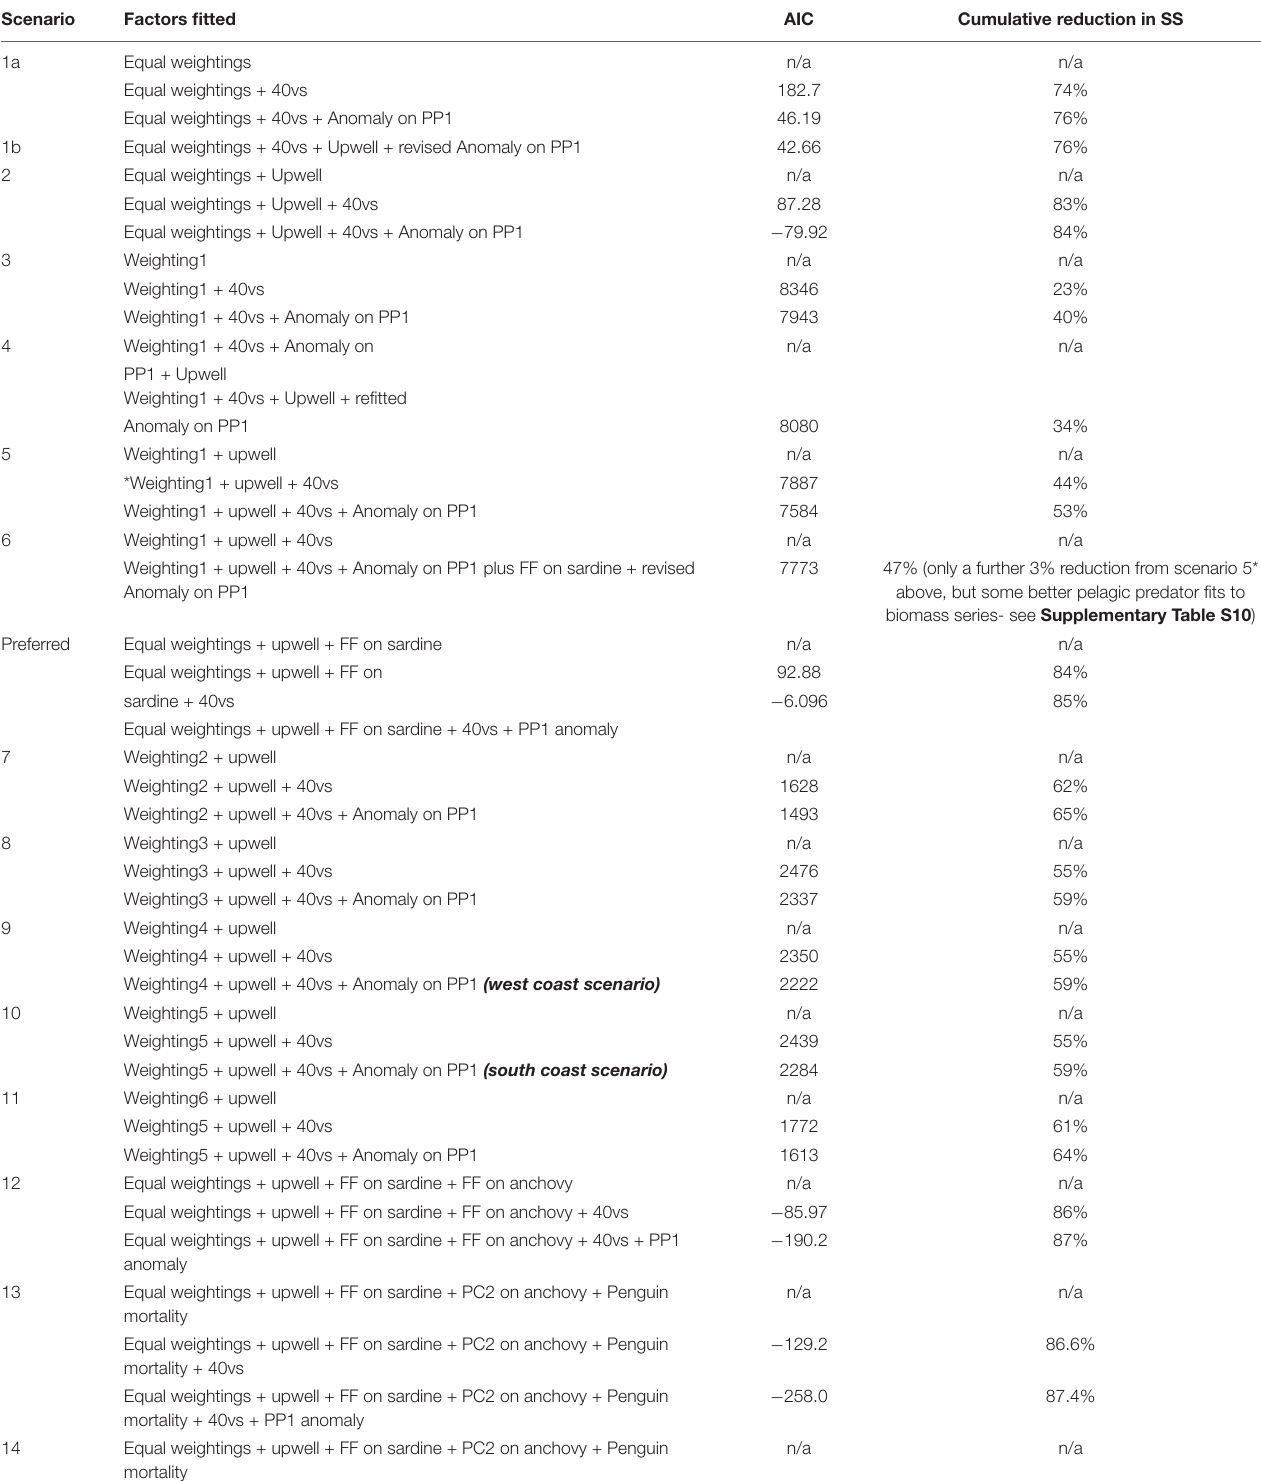
TABLE 3 | Scenarios examined to improve model fit to data, when the data-derived upwelling anomaly ( upwell – see footnote) is applied to large phytoplankton (apart from in Scenario 1), 40 vulnerabilities are fitted for the most influential predator-prey interactions (40vs) and a hypothetical environmental anomaly (18 spline points) is applied to small phytoplankton (Anomaly on